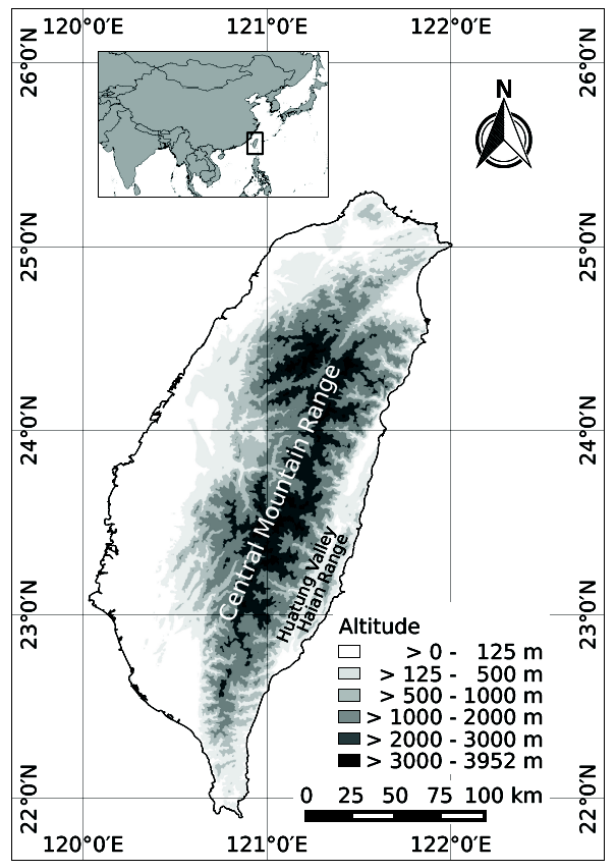
Figure 1. Topography (derived from SRTM DEM, U.S. Geological Survey) and geographical location of